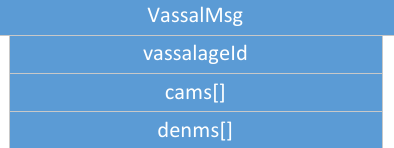
Figure 4. VassalMsg : containing vehicle status (cams[]) and event (denms[]) data from vehicles within a certain vassalage indicated by vassalageId